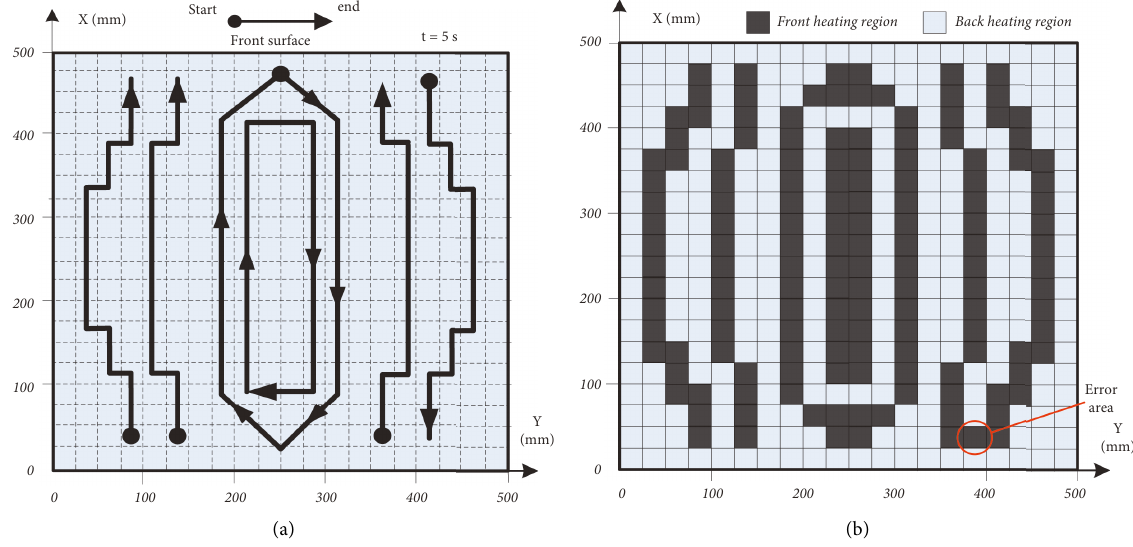
Figure 11: (a) Desire trajectories landing for heat inductor and (b) predicted regions